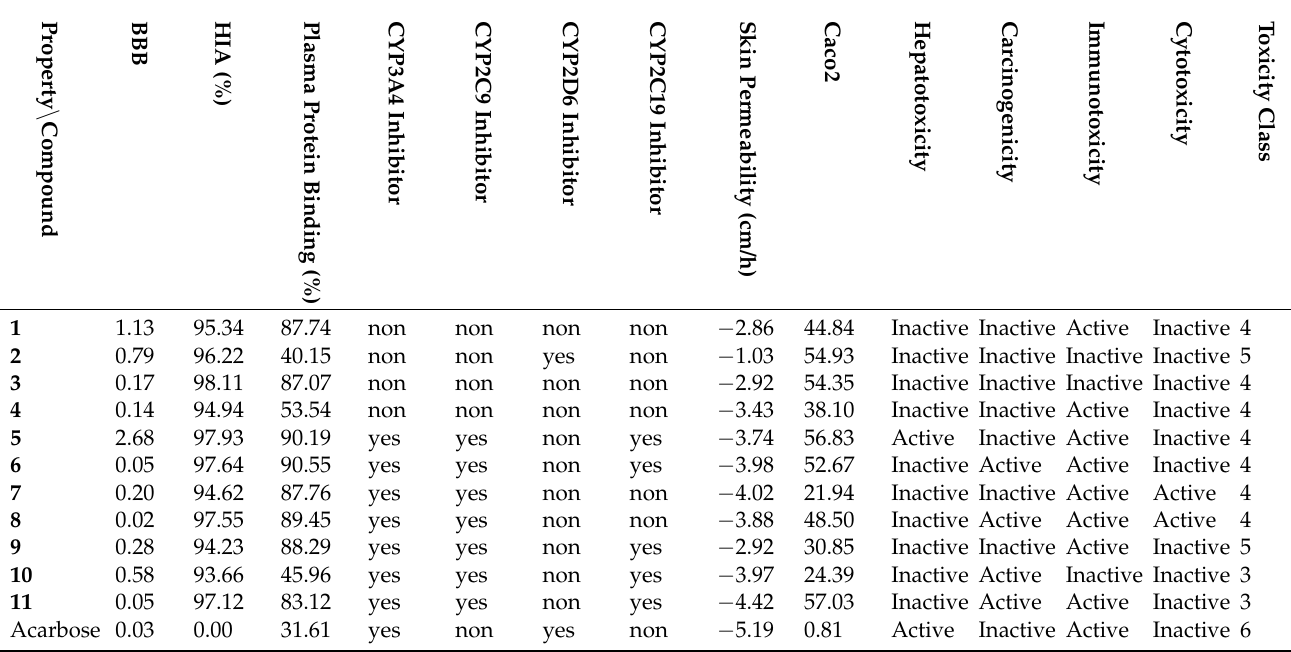
Table 3. ADME/Tox properties for compounds 1 – 11 and the reference,